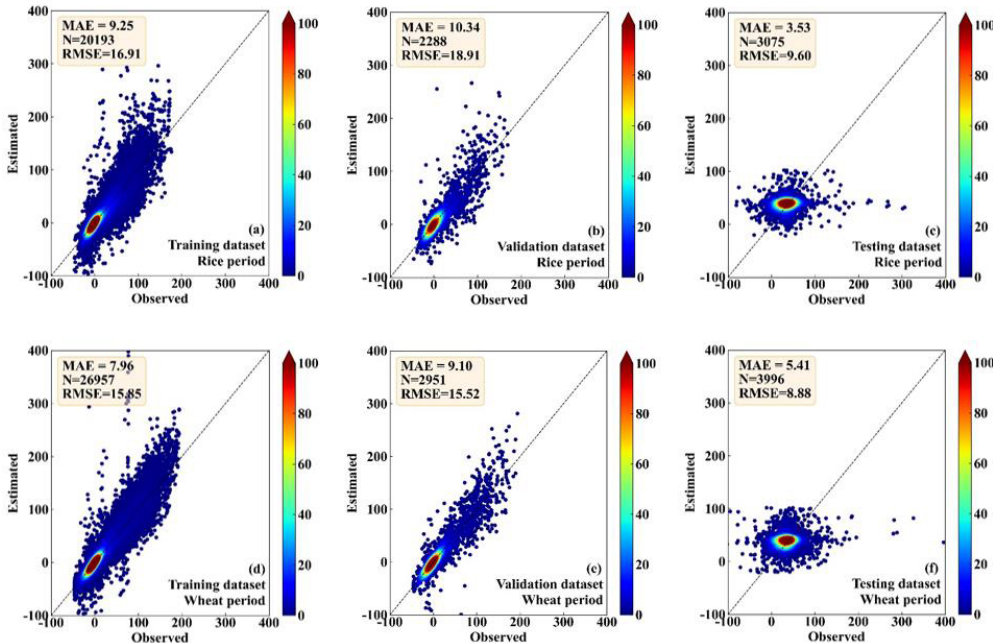
Figure 5. Scatter density plots of the observed and the RF-estimated H values, (a) and (d) for the training dataset, (b) and (e) for the validation dataset, and (c) and (f) for the testing dataset. And (a) , (b) , and (c) are in the period of rice, while (d) , (e) , and (f) are in the period of